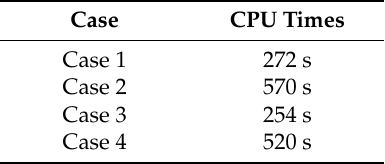
Table 6. CPU times for each